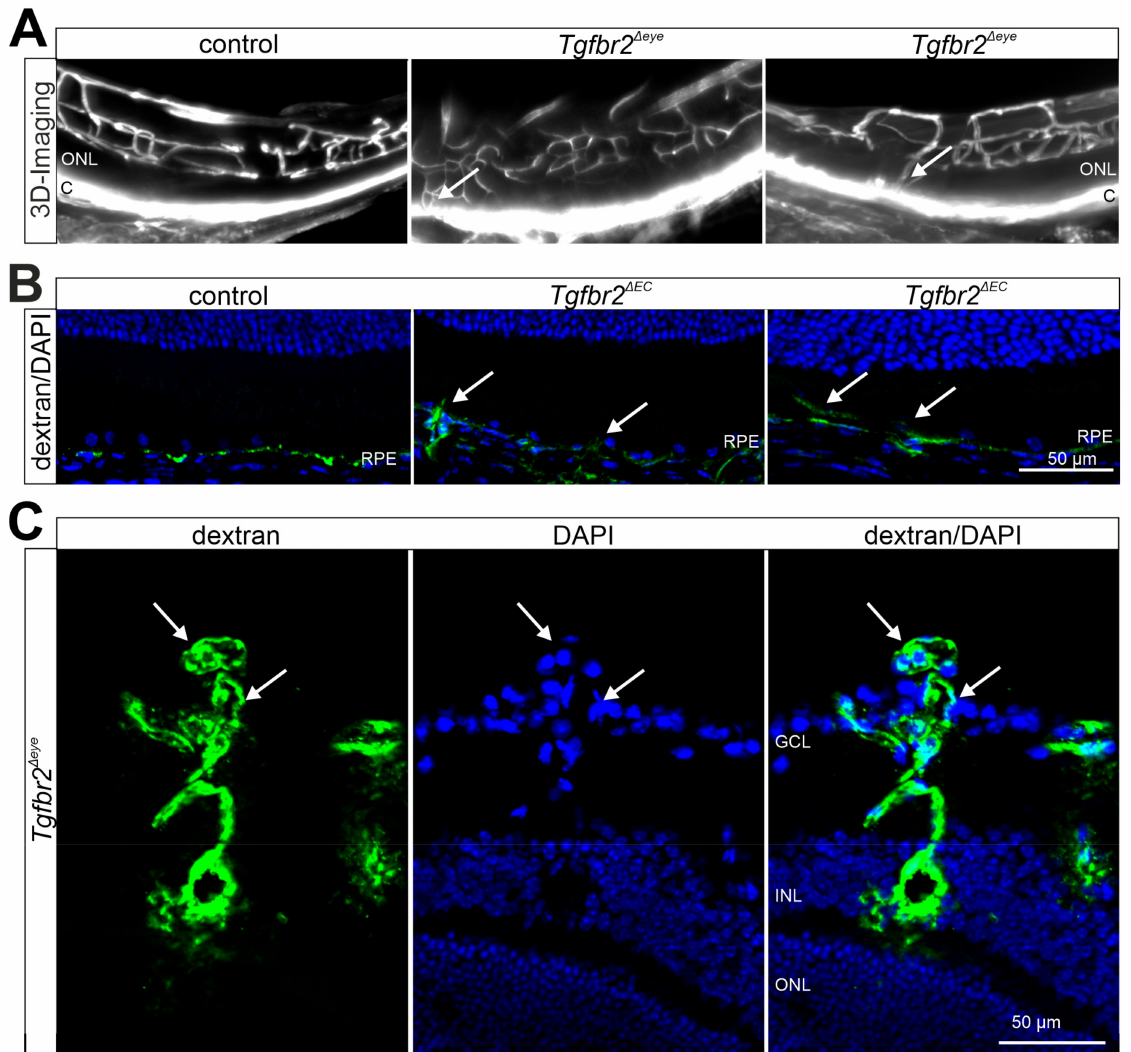
Figure 4. Deletion of TGF β signaling results in retinal and choroidal neovascularization. ( A ) Light-sheet fluorescence microscopy of cleared eyes of 6-week-old lectin-injected Tgfbr2 ∆ eye mice and a control littermate. The control mouse shows an essentially regular arborized retinal vasculature. The Tgfbr2 ∆ eye mice have an irregular arrangement of the retinal plexus and develop choroidal neovascularization forming anastomoses between retinal and choroidal vessels (arrows). ( B ) FITC-dextran (green) perfused retinal meridional sections of 6-week-old Tgfbr2 ∆ EC mice and a control littermate. White arrows point toward tracer leakage in the retinal pigment epithelium (RPE; middle panel) and choroidal neovascularization (right panel) invading the RPE and subretinal space. Nuclei are DAPI stained (blue). ( C ) Meridional section of a 6-week-old FITC-dextran (green) perfused Tgfbr2 ∆ eye retina shows neovascularization into the vitreous (white arrows), similar to what can be observed in patients suffering from proliferative diabetic retinopathy. Nuclei are DAPI stained (blue). The original data which we show in a slightly modified representation here, have been published in [35,41]. GCL = ganglion cell layer, INL = inner nuclear layer, ONL = outer nuclear layer, RPE = retinal pigment